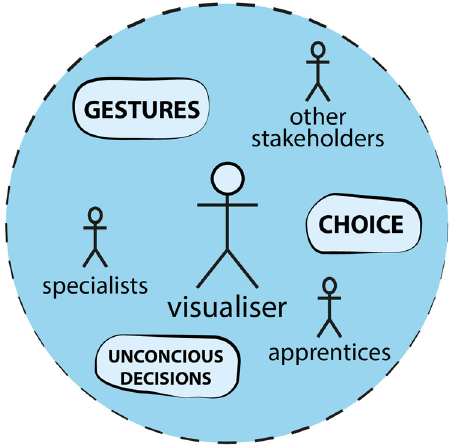
Figure 1: The visualiser ’ s personal social remit, in which ( unconscious ) choices are made, and other participants such as apprentices and team members in fl uence the decision - making process. Image by the